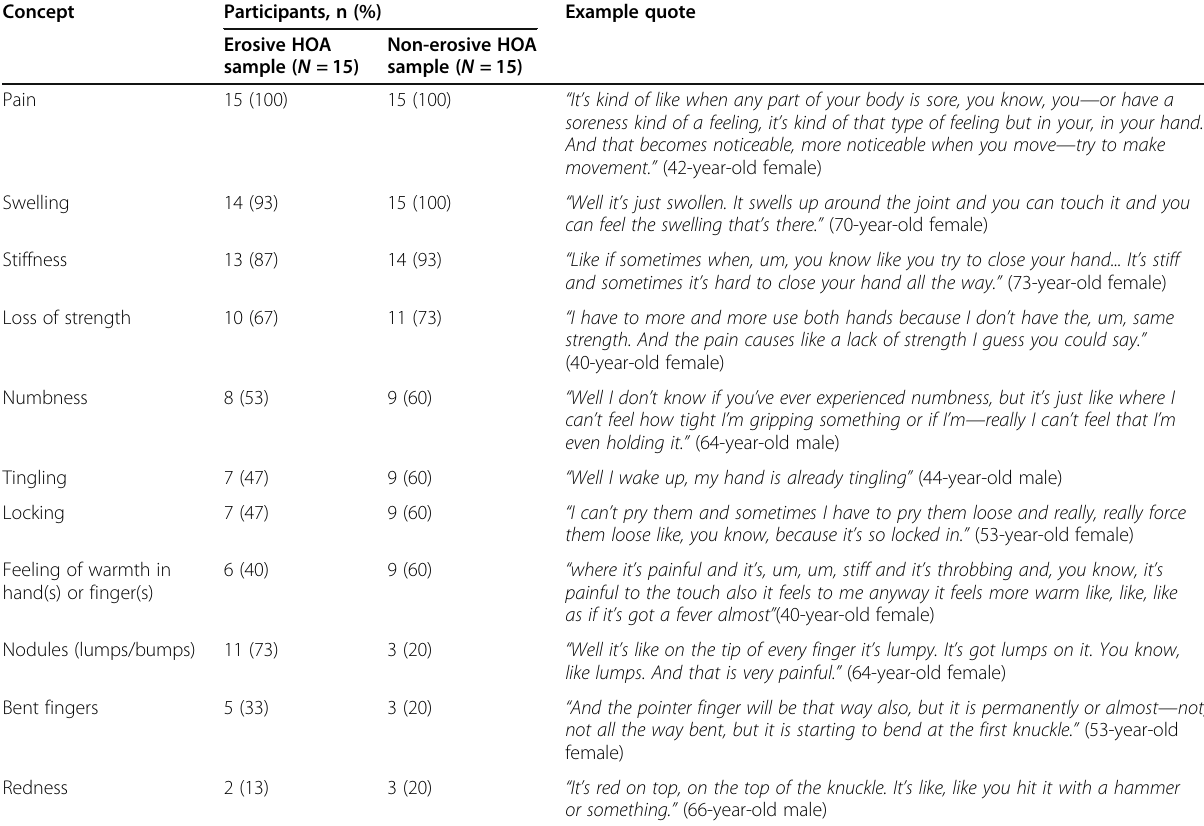
Table 2 Summary of symptoms reported in the concept elicitation interviews Concept